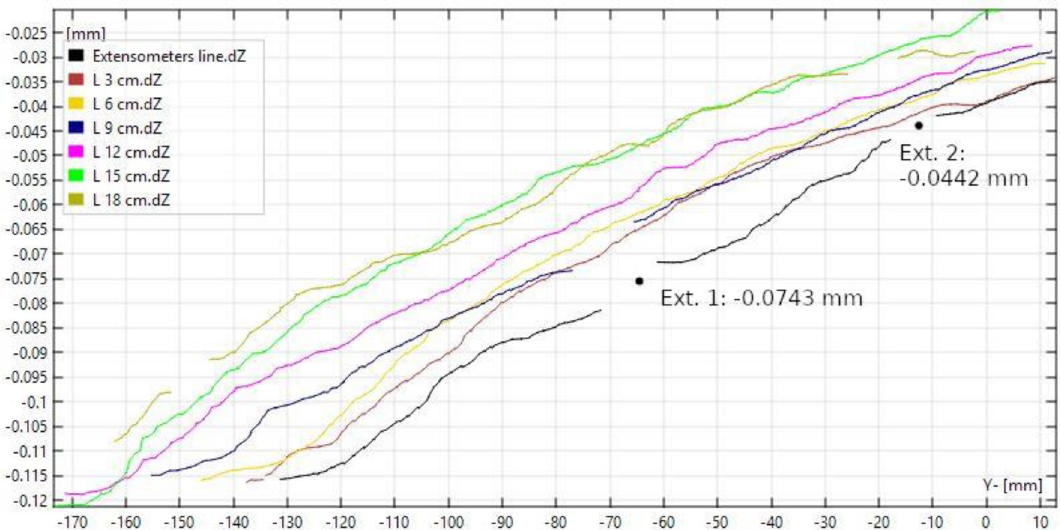
Figure 9. Vertical displacement of the pavement along the sampled lines at step 16.